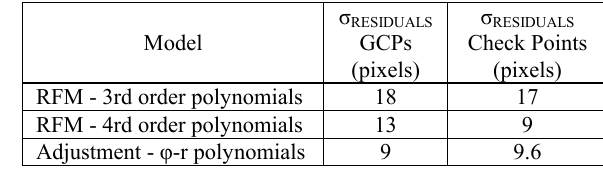
Table 2: The standard deviations of the residuals in the Ground Control Points and in the Check Points.